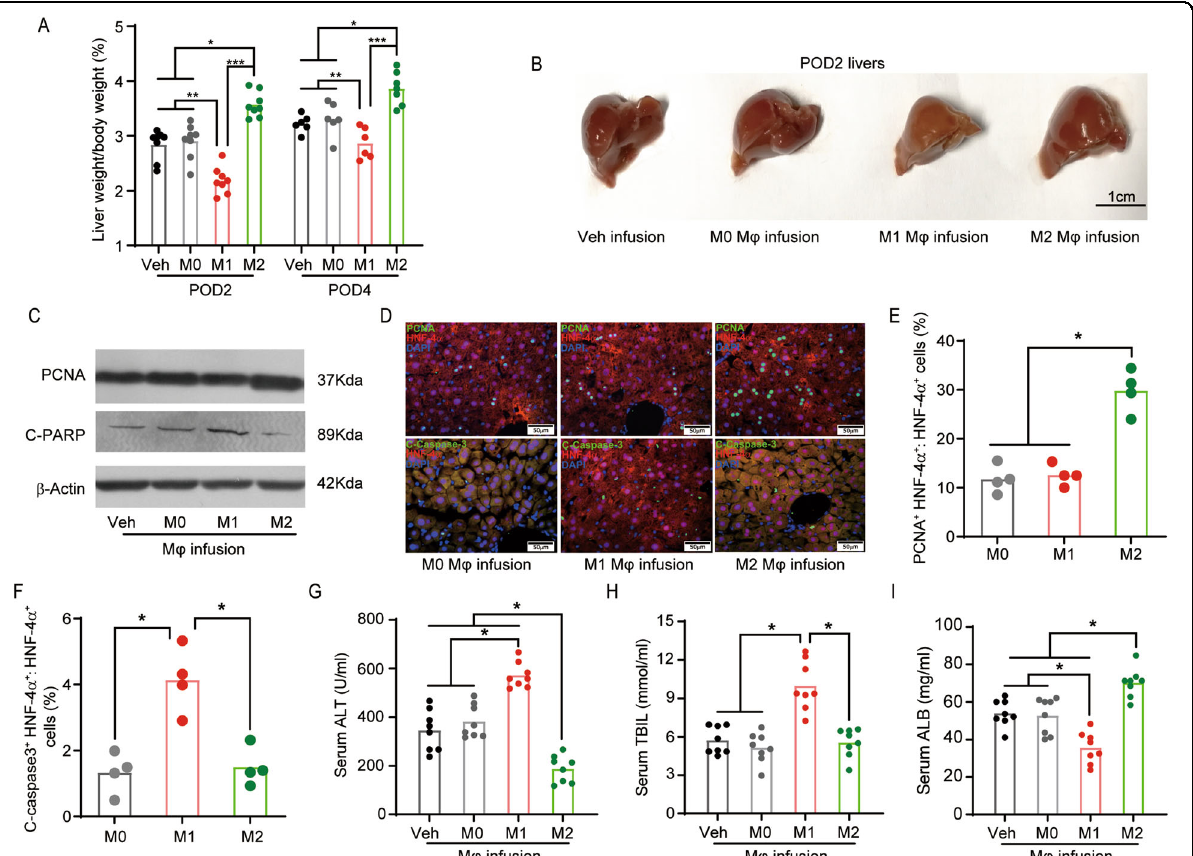
Fig. 4 Infusion of M1 and M2 BMDMs exerts distinct effects on promoting either injury or regeneration in mouse liver after partial hepatectomy. Mice with infusion of polarized BMDMs were sacri fi ced at 2 days or 4 days after hepatectomy (POD2 or POD4), and the remnant liver tissues were collected to examine injury and regeneration. Remnant liver tissues collected at 2 days after hepatectomy were subjected to examination of proliferation and apoptosis. A Liver mass index (liver weight:body weight in %) was monitored after partial hepatectomy. B Representative images of the remnant liver after BMDM infusion. C Protein levels of proliferation marker PCNA and apoptosis marker C-PARP in the remnant livers were measured by immunoblotting. D Sections of liver tissues were co-stained with hepatocyte marker HNF-4 α and proliferation marker PCNA or apoptosis marker C-Caspase 3. Top: representative images of staining of PCNA (green) and HNF-4 α (red). Bottom: representative images of staining of C-Caspase 3 (green) and HNF-4 α (red). Nuclei were counterstained with DAPI (blue). E , F The positive cells were counted, the percentage of PCNA + and HNF-4 α + hepatocytes vs. HNF-4 α + cells ( E ) and the percentage of C-Caspase 3 + and HNF-4 α + hepatocytes vs. HNF-4 α + cells ( F ) were calculated. G – I Serum levels of ALT, TBIL, and ALB were determined at 2 days after surgery. Images in B – D represent results from fi ve individual mice in each group; * p < 0.05, ** p < 0.01, *** p <